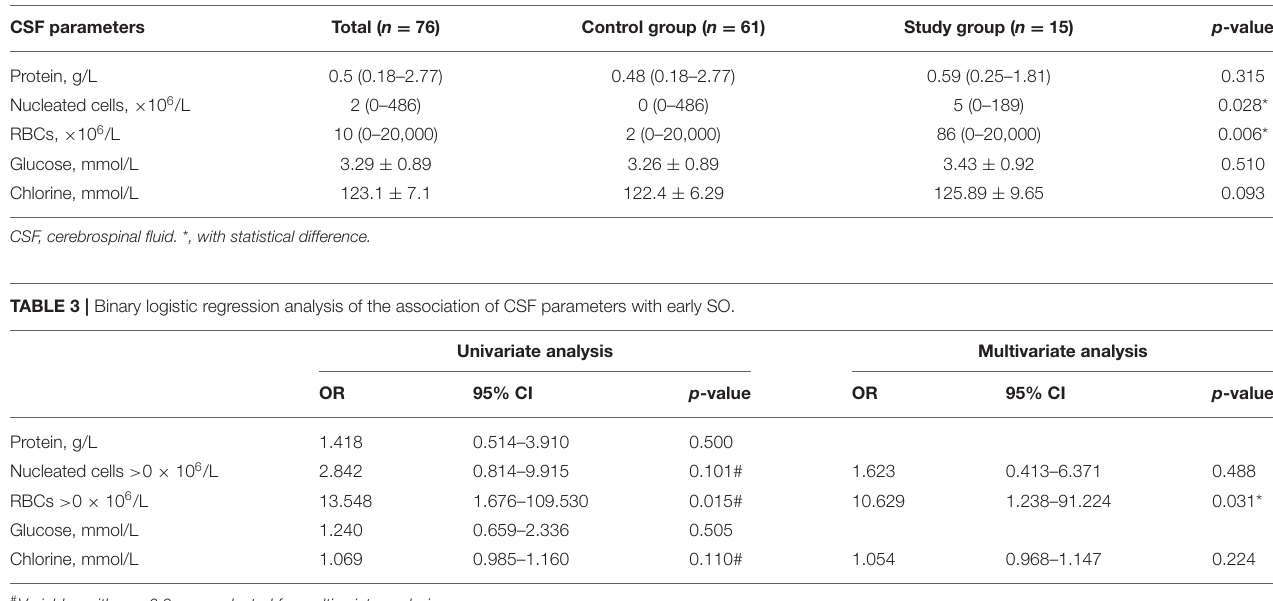
TABLE 2 | Comparison of CSF parameters between two groups.